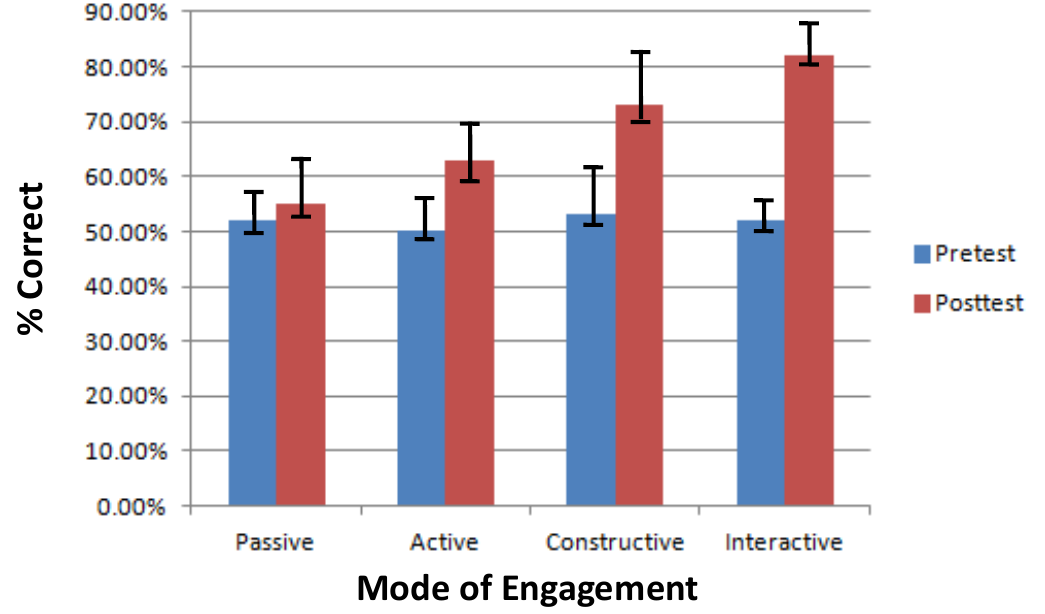
Figure 7. Results from [113] shows the effectiveness of interactive learning compared to other modes of